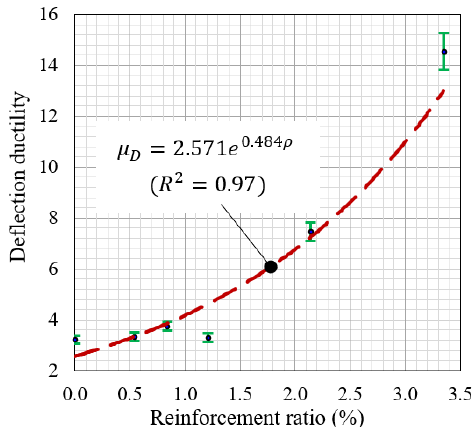
Figure 12. Reinforcement ratio and deflection – ductility relations.